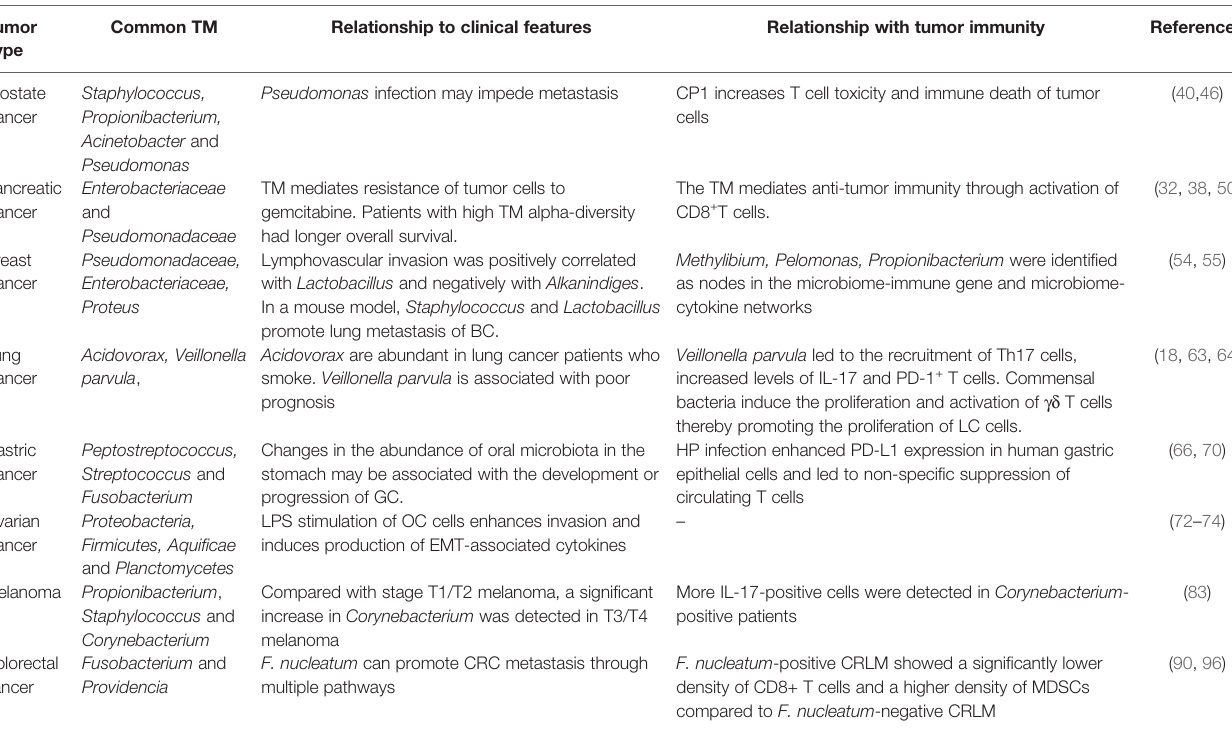
TABLE 1 | Composition of the TM in tumors and its relationship to clinical features and tumor